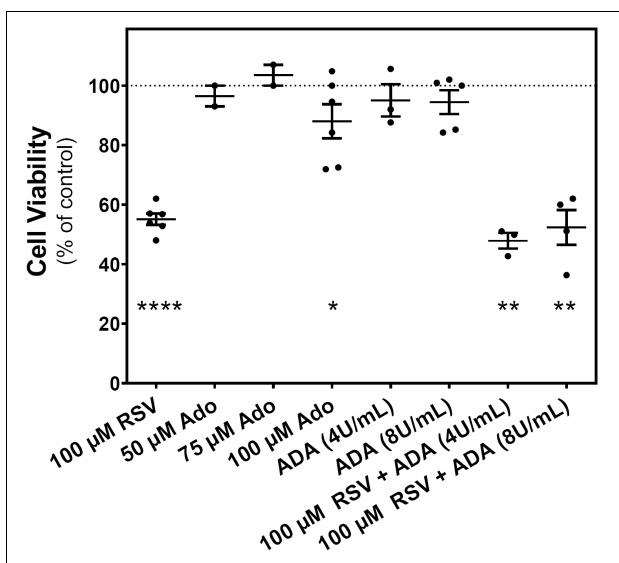
FIGURE 7 | Effect of adenosine on C6 glioma cells growth. Cell viability was measured on C6 glioma cells after 24 h of treatment with 100 µ M RSV; 50, 75, and 100 µ M adenosine (Ado); 4 or 8 U/mL ADA; or a combination (ADA + RSV). Data are means ± SEM of three to six independent experiments. * p < 0.05, ** p < 0.01, and **** p < 0.0001 significantly different from the control condition according to Student’s t